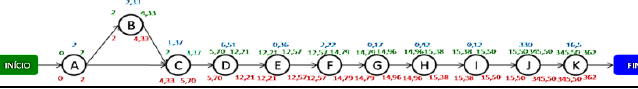
Figura 2: Croqui do Layout do setor de produção da padaria. Fonte: Autores, (2018).